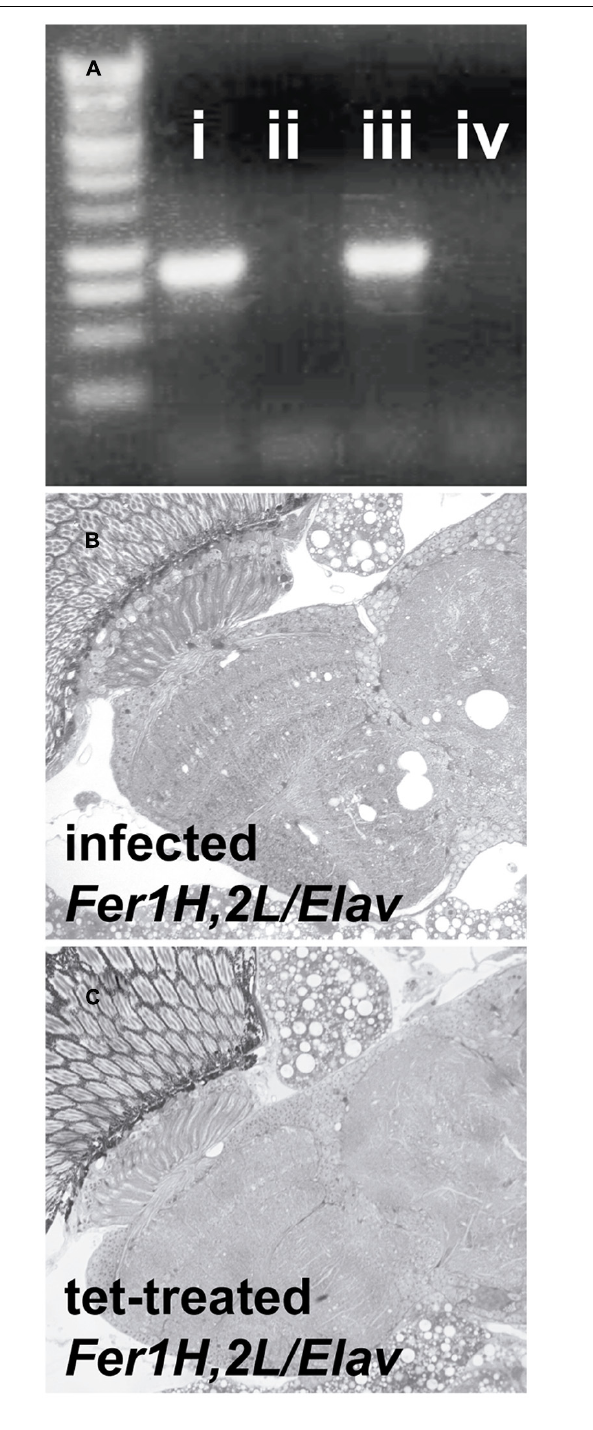
FIGURE 6 |Treatment with the antibiotic tetracycline cured the flies from the Wolbachia infection. (A) PCR detection of the Wolbachia ribosomal 16S gene in (i) infected D. simulans (ii) tetracycline-treated D. simulans (iii) infected UAS-Fer1HCH, UAS-Fer2LCH on X ( D. melanogaster ) (iv) tetracycline-treated UAS-Fer1HCH, UAS-Fer2LCH on X (B) Plastic embedded sections of heads from infected (mothers from (iii) and (C) tetracycline-treated (mothers from iv) Elav/UAS-Fer1HCH, UAS-Fer2LCH adults at 40 days of